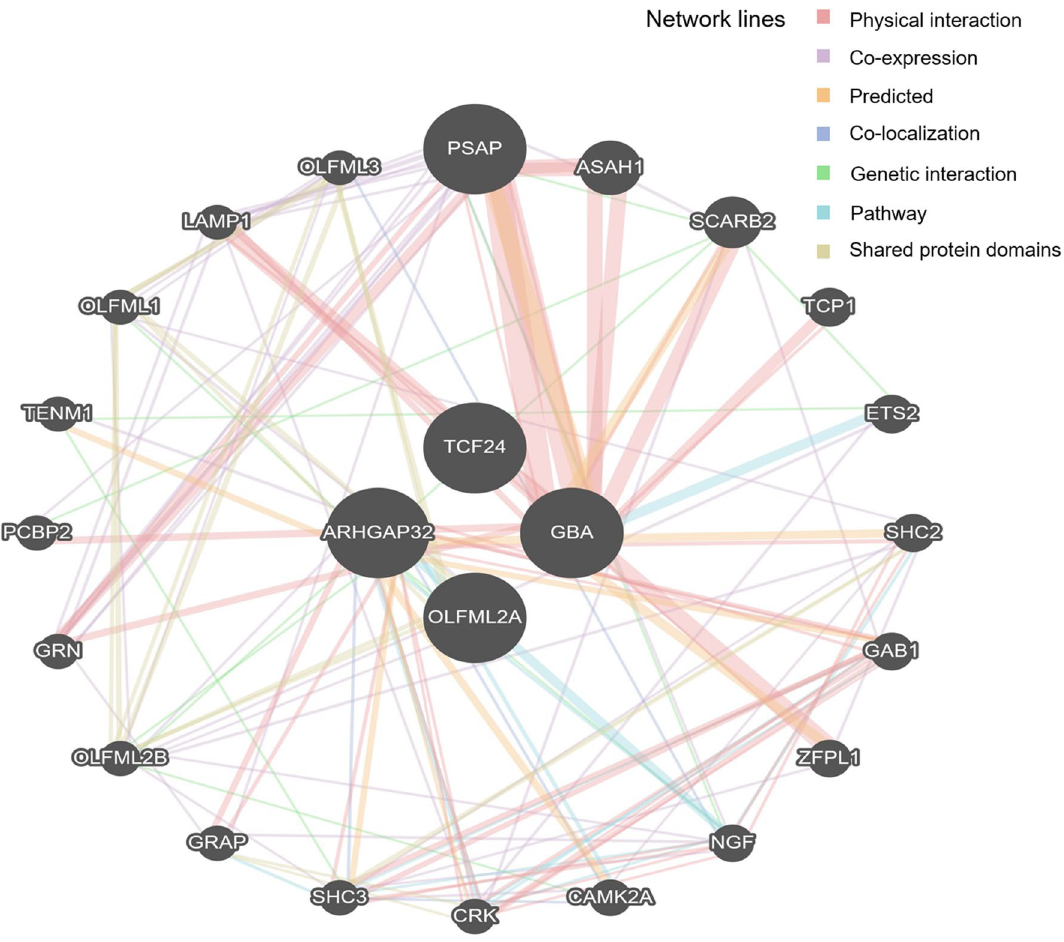
network included neighboring genes correlated with four hub genes. The width of individual lines indicates the intensity of the interaction between proteins. The colors in each line indicate multiple functions including physical interaction, co-expression, prediction, co-localization, genetic interaction, pathways, and shared protein domains. The multiple protein interaction map was drawn by using the GeneMANIA program (https:// genem ania.